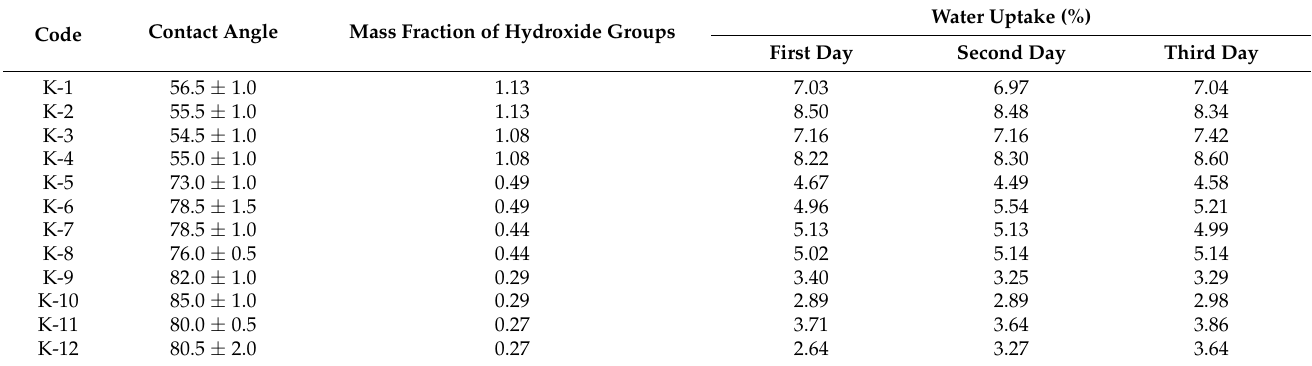
Figure 10 . Contact angle of water for the elastomer samples K-1–K-12. Figure 10. Contact angle of water for the elastomer samples K-1–K-12. Table 6. Contact angle of water for the synthesized elastomers.